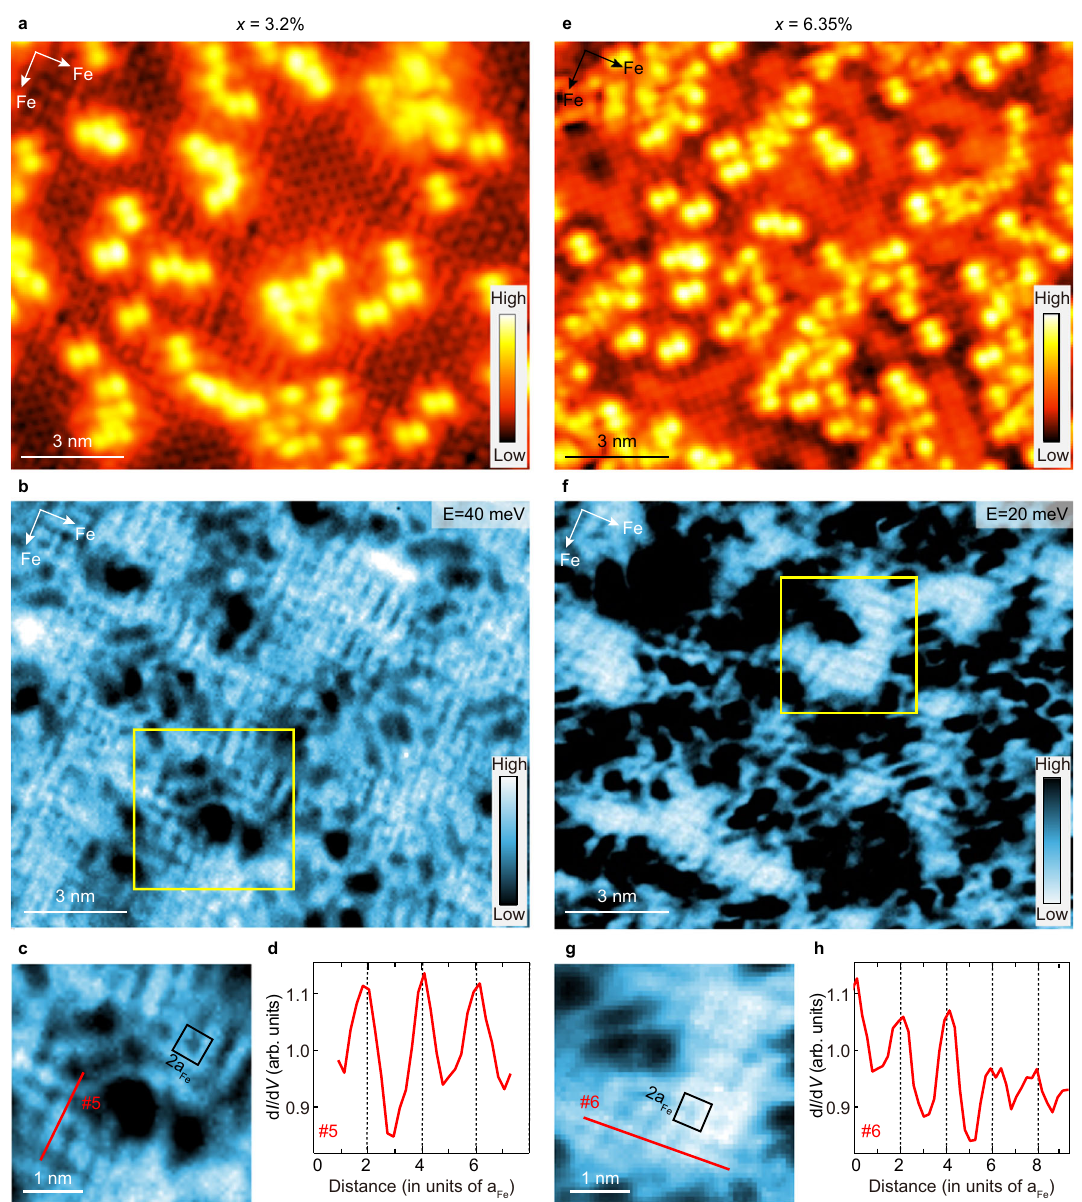
Fig. 4 | Spatial LDOS modulations in Fe 1 − x Se regions with x =3.2% and 6.35%. a , b Atomically resolved topographic image and corresponding d I/ d V map at E =40meV for an Fe x =3.2%. Measurement conditions for a : 1- x Se region with I V I Δ V =2mV. c Theenlargedimage V b =40mV, t =50pAand b : b =40mV, t =50pA, oftheareamarkedbytheyellowboxin( b ).Theblackboxshowstheunitcellofthe charge order with a 2a Fe period. d Spatial LDOS pro fi les taken along cut #5 in ( c ).